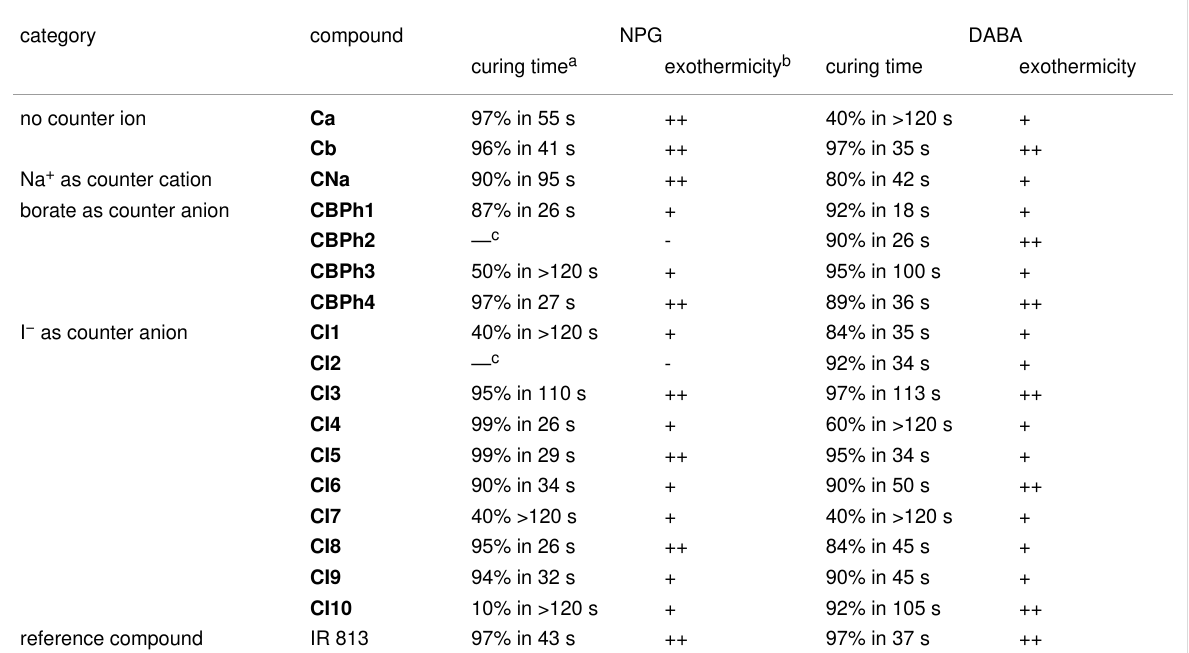
Table 1: Quantitative estimations of the polymerization time of PETIA monomer using a NIR dye/iod/amine 0.1:3:2, w/w/w system upon exposure to a laser diode at 785 nm (0.9 W/cm²), thickness = 1.4 mm, under air and at room temperature. The irradiation starts at t = 10 s.